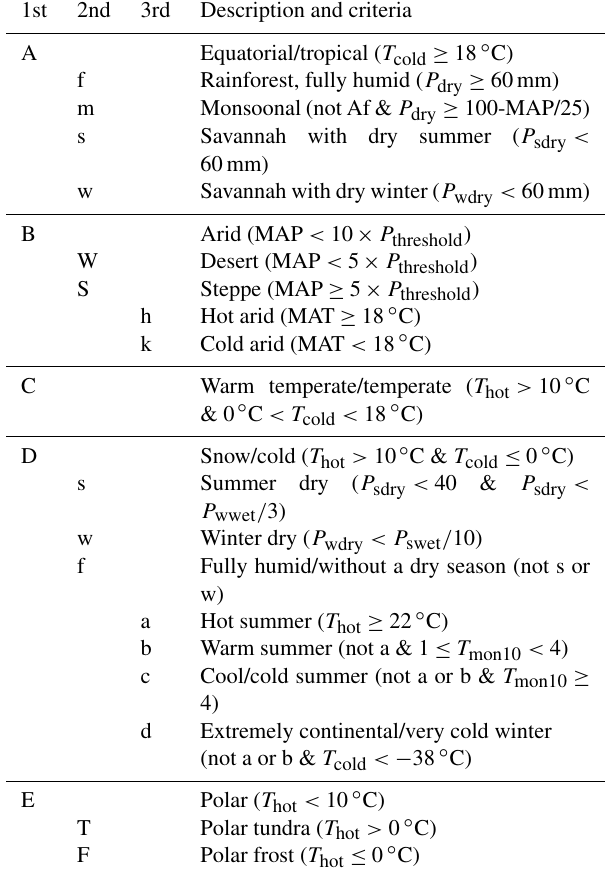
Table 3. Description of Köppen–Geiger climate symbols and defin- ing criteria (Kottek et al., 2006; Peel et al., 2007). MAP: mean an- nual precipitation; MAT: mean annual temperature; T hot : tempera- ture of the hottest month; T cold : temperature of the coldest month; T mon10 : number of months where the temperature is above 10 ◦ C; P dry : precipitation of the driest month; P sdry : precipitation of the driest month in summer; P wdry : precipitation of the driest month in winter; P swet : precipitation of the wettest month in summer; P wwet : precipitation of the wettest month in winter; P threshold : varies ac- cording to the following rules – if 70% of MAP occurs in winter, then P threshold = 2 × MAT; if 70% of MAP occurs in summer, then P threshold = 2 × MAT + 28 ◦ C ; otherwise P threshold = 2 × MAT +